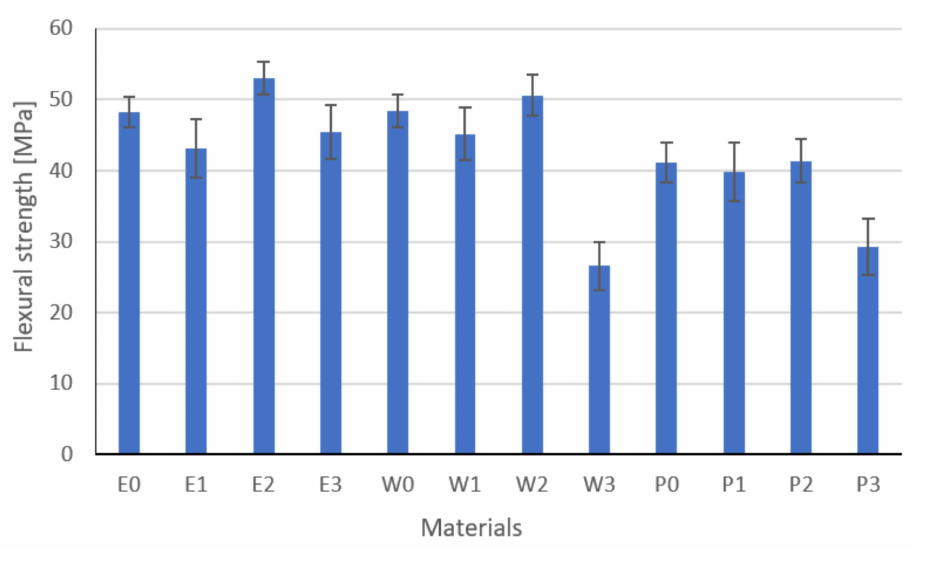
Figure 14. Flexural strength results.